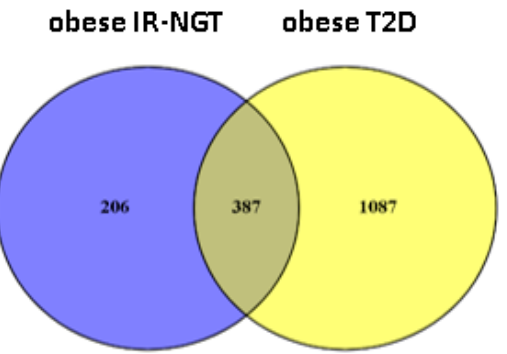
Figure 2. Venn diagram of differential expression analysis DEGs of a comparison between both obese IR-NGT and obese T2D groups. Yellow color represents obese T2D vs. lean, and the blue color represents Obese IR-NGT vs.